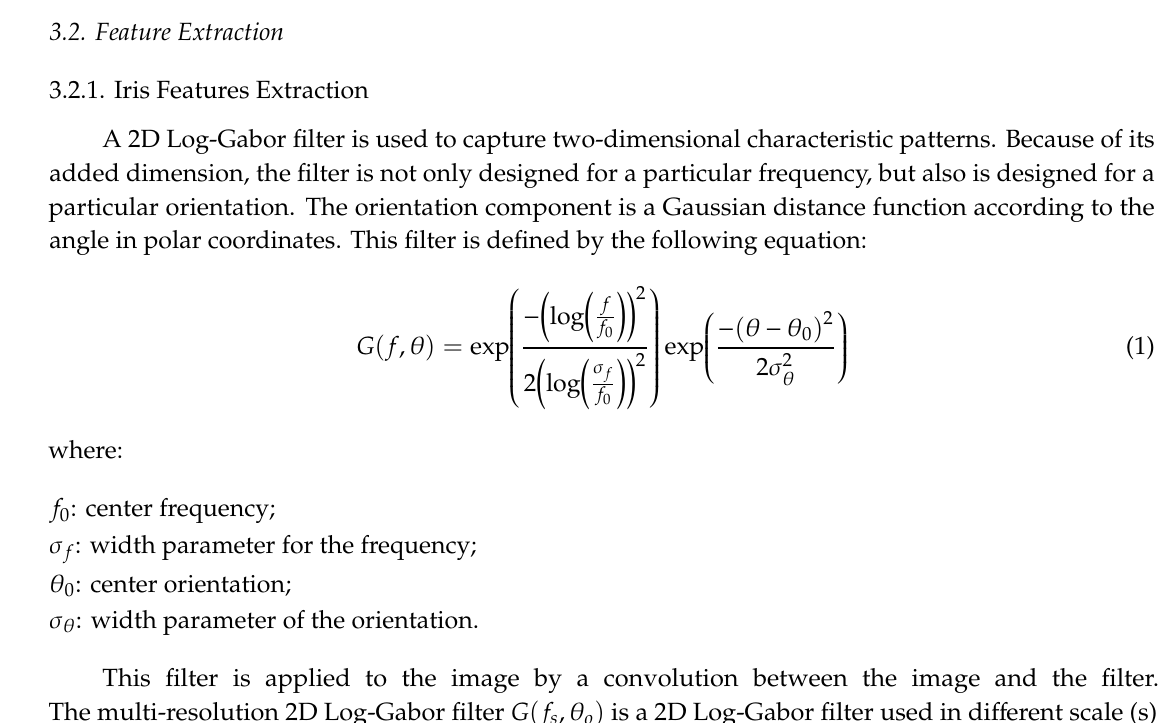
Figure 3. Iris segmentation and normalization.